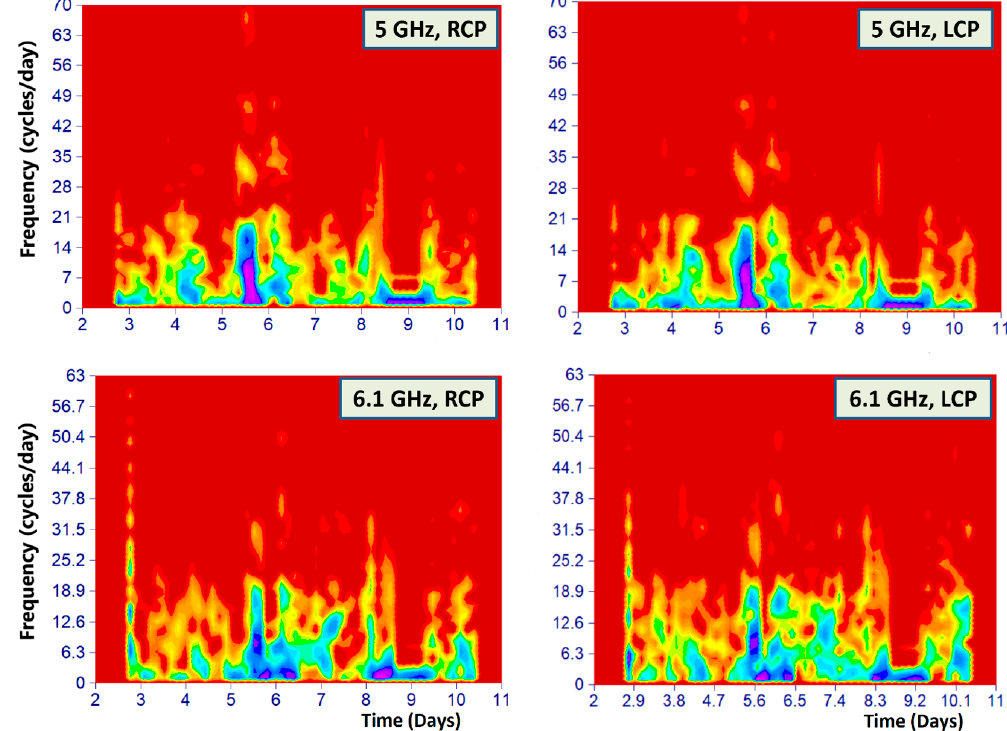
Figure 3. Spectrograms for 3C 371 (2–10 September 2019). The following plotting parameters were used for the spectrograms: Bartlett spectral window, sliding window width 128 points, spectral window overlap 87%, FFT length-1024 frequencies, visualization in normalized to 0 decibels (dB0). Amplitude color gradations from violet (large amplitude) to blue, green, orange and dark red (background). As can be seen in the figures, variability is present only in the form of short-term irregular variations and a noise